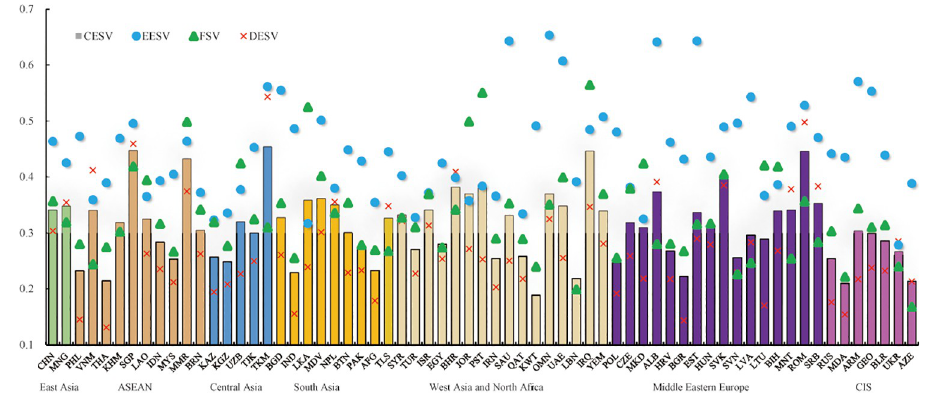
Fig 4. Values of EESV, FSV, DESV and CESV of each BRI country.